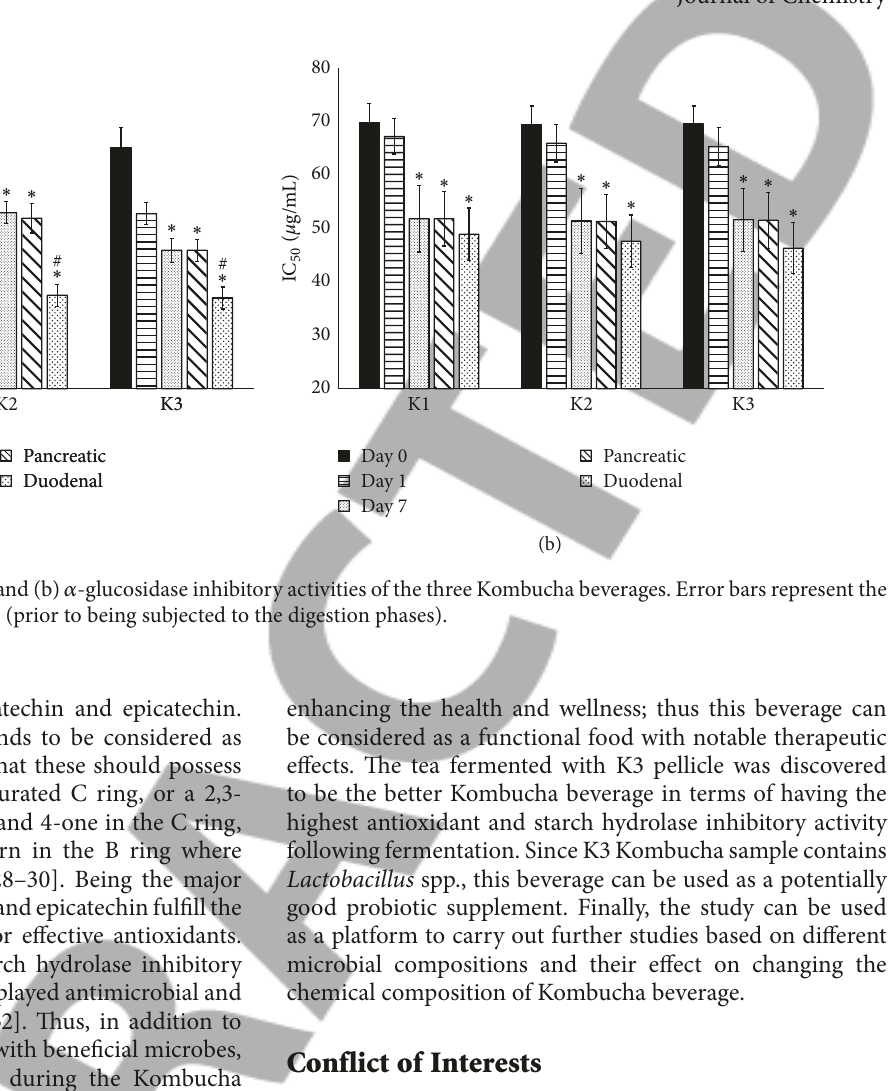
group of compounds, especially catechin and